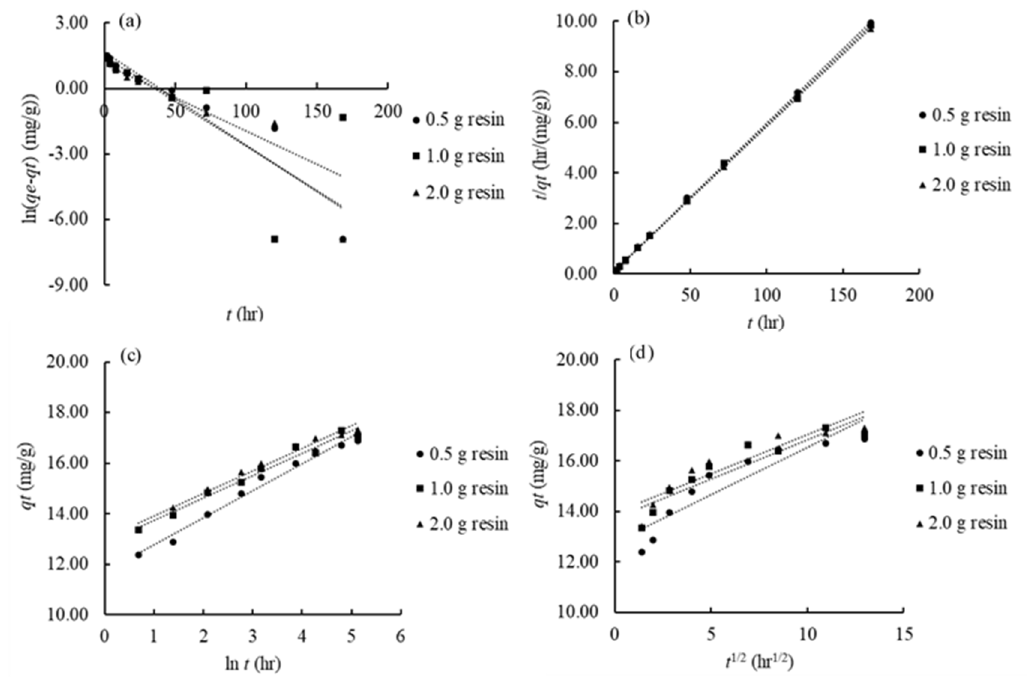
Figure 8. Linear plot of ( a ) pseudo-first-order model, ( b ) pseudo-second-order model, ( c ) Elovich model, ( d ) intra-particle diffusion model for the P desorption kinetic data shown in Figure 8.